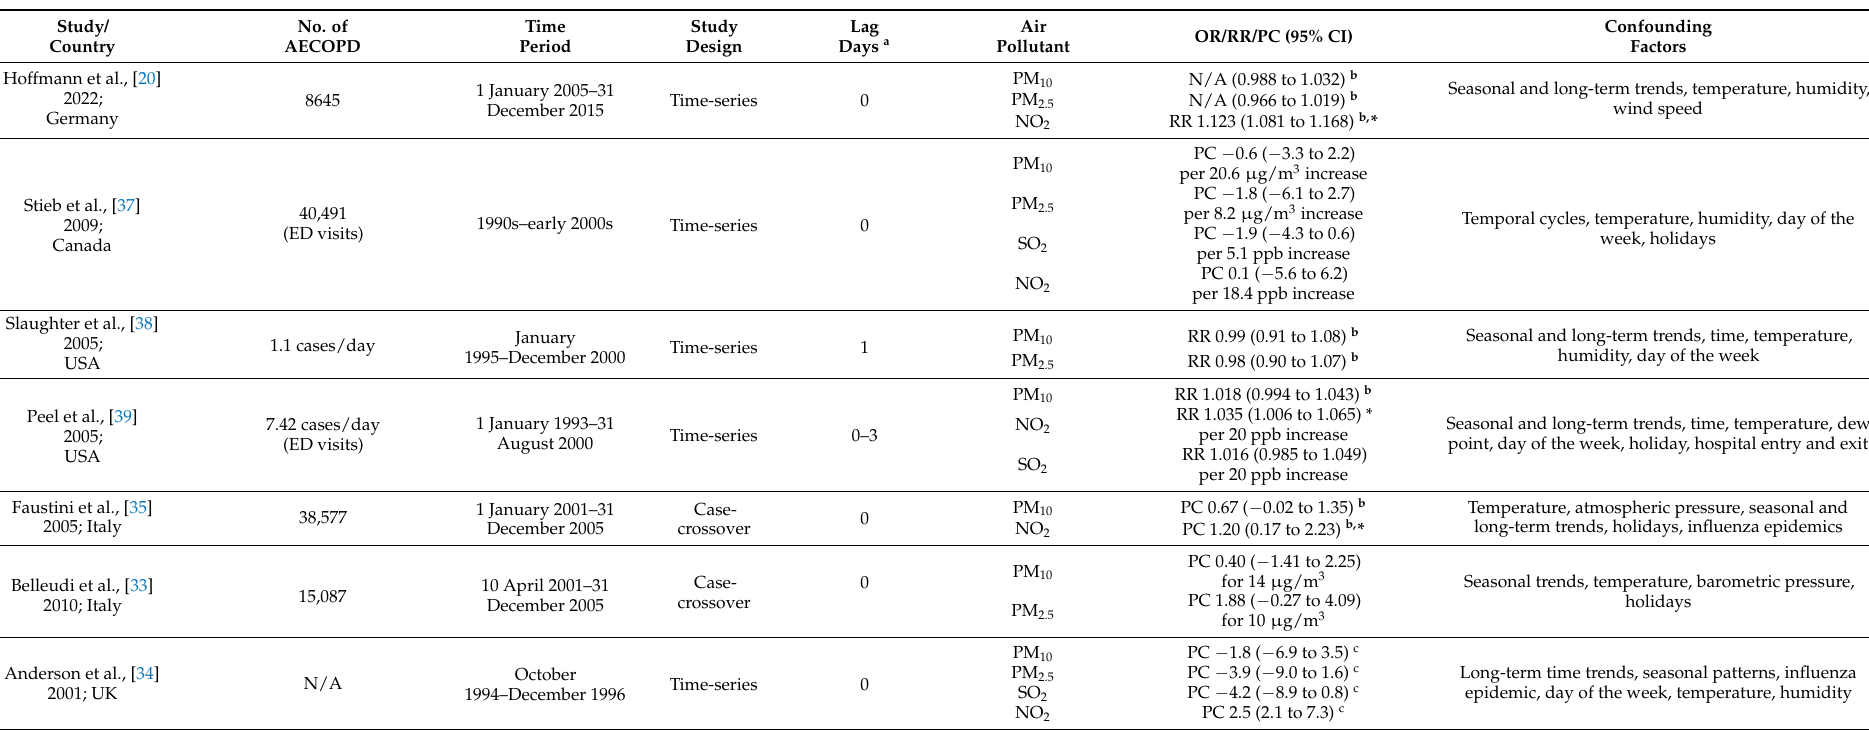
Table 6. Selected studies demonstrating a negative association between air pollutant exposure and number of AECOPD hospitalizations/emergency department